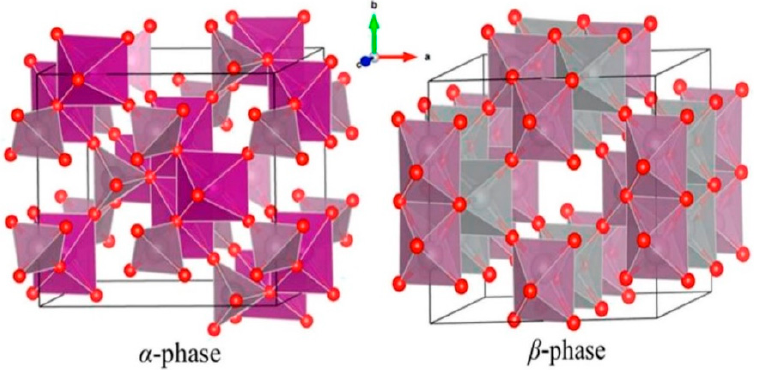
Figure 2. The monoclinic crystal structures of α -NiMoO 4 and β -NiMoO 4 [21]. Reproduced from Ref. [21] with permission from AIP Publishing, 2018.